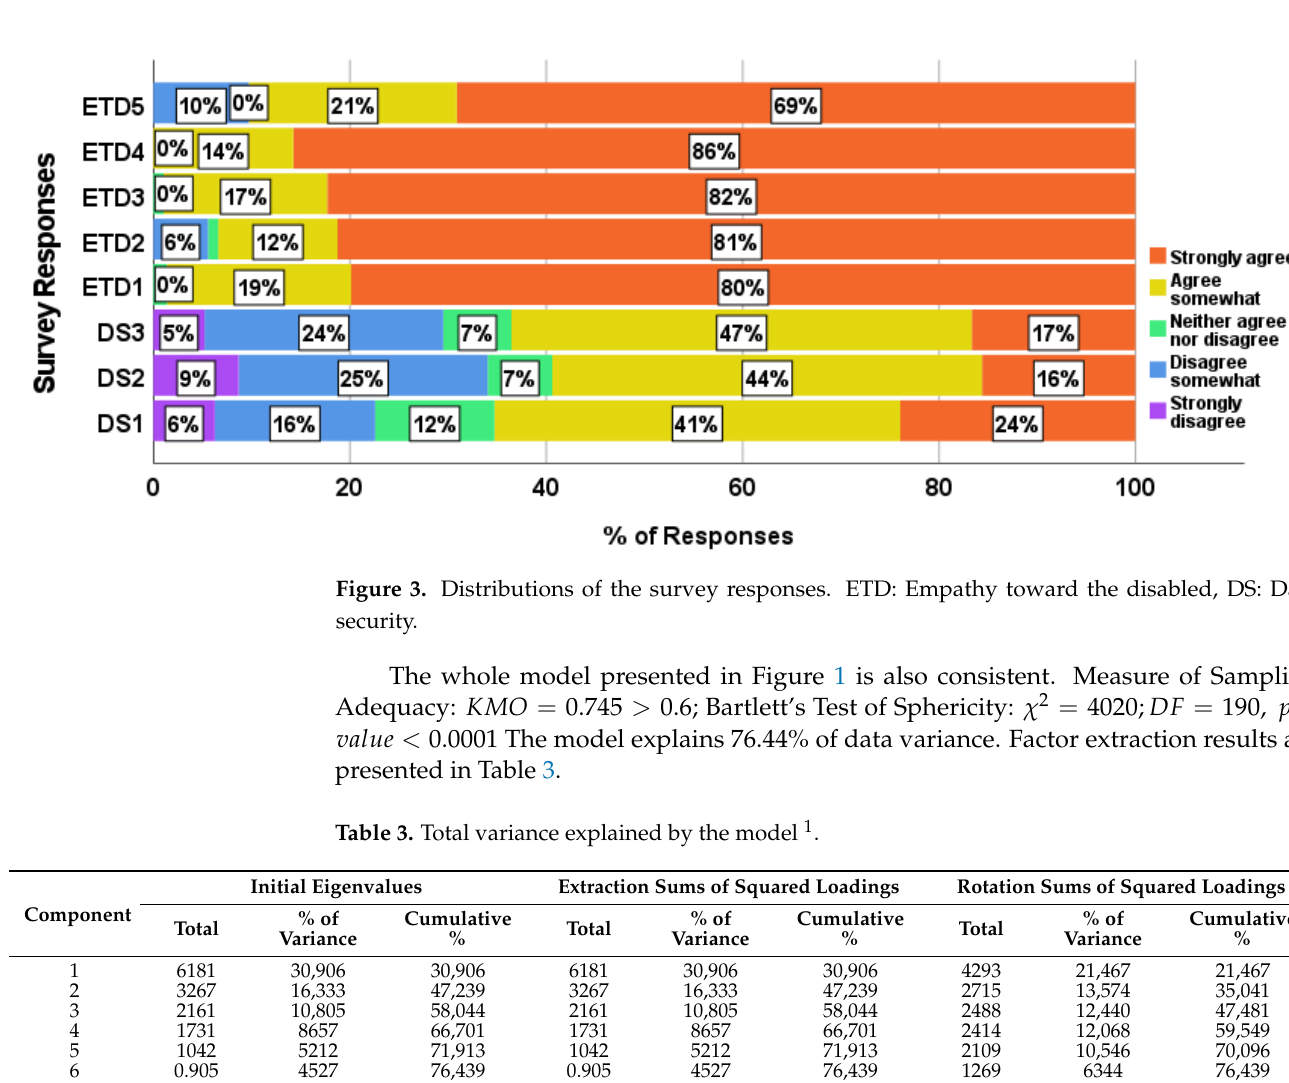
Figure 2. Distributions of survey responses. TT: Trust in IoT devices, AC: Acceptance of IoT devices, TG: Trust in city authorities, PU–Perceived usefulness.